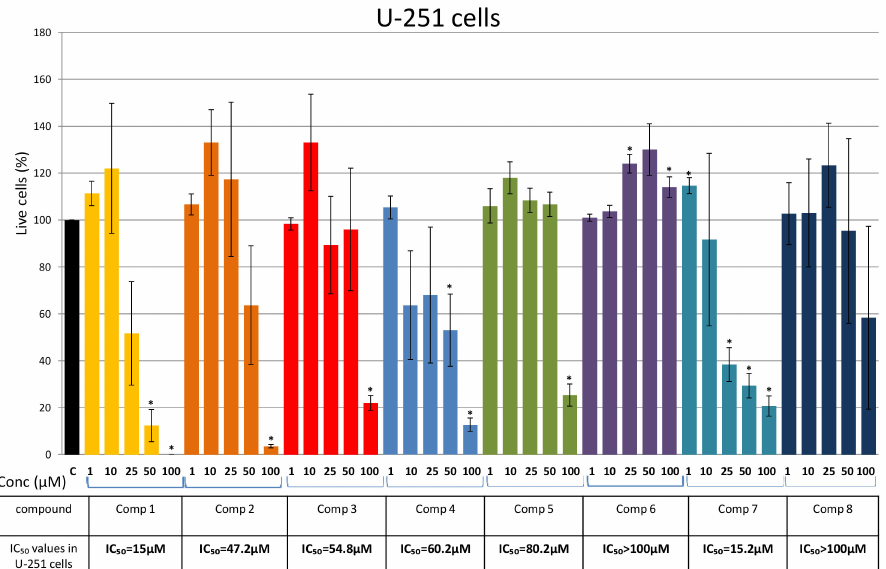
Figure 8. Effects of Compounds 1–8 on U-251 cells. Cells were treated for 48 h with increasing concentrations (1 µ M, 10 µ M, 25 µ M, 50 µ M, and 100 µ M) of the tested compounds and cell viability was assessed using an MTT assay and expressed as the percentage of absorbance relative to the vehicle control (U251 cells treated with DMSO), which was set at 100%. Data are presented as the mean ± SEM of at least three independent experiments. An asterisk denotes significant difference from the control (* p < 0.05). SEM—standard error of the